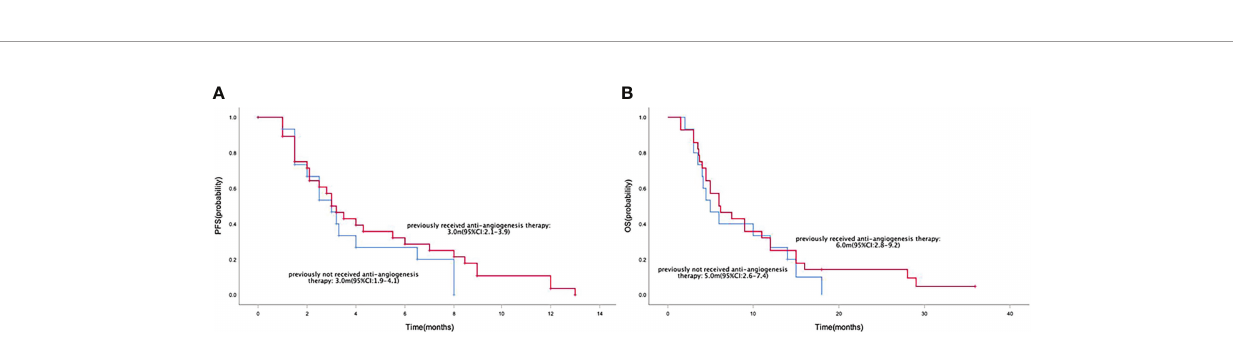
FIGURE 3 | Kaplan-Meier curve of PFS (A) and OS (B) in anlotinib monotherapy and combination therapy population. Kaplan-Meier curve of PFS (C) and OS (D) in anlotinib combined with chemotherapy and PD-1 inhibitor population.